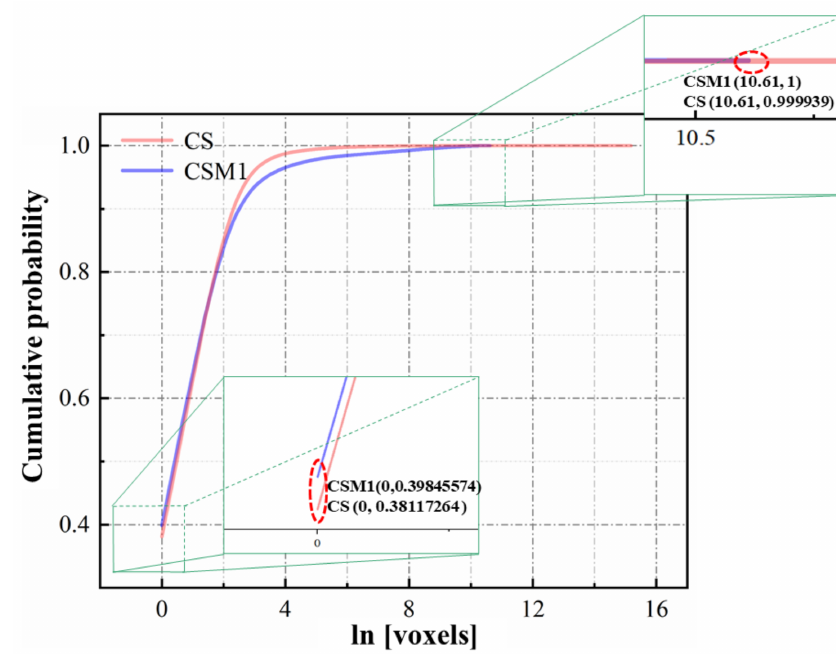
Figure 19. Cumulative probability of pore voxels in CS and CSM1 5%